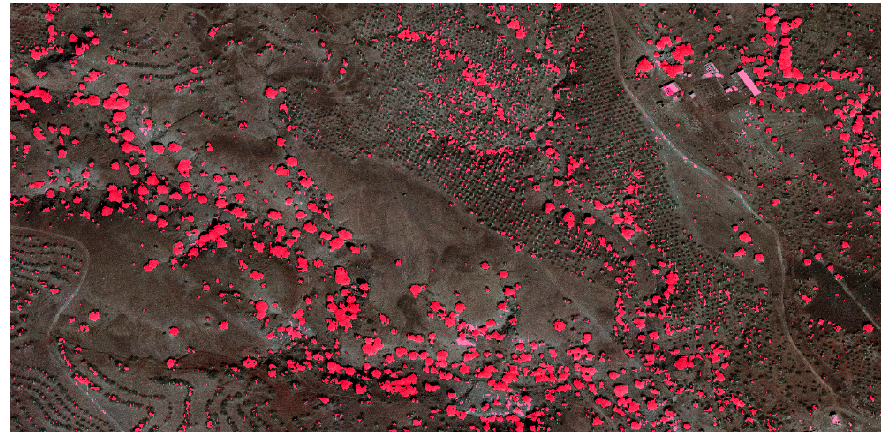
Figure 3. Tree canopy map obtained by visible atmospherically resistant index (VARI) image processing.